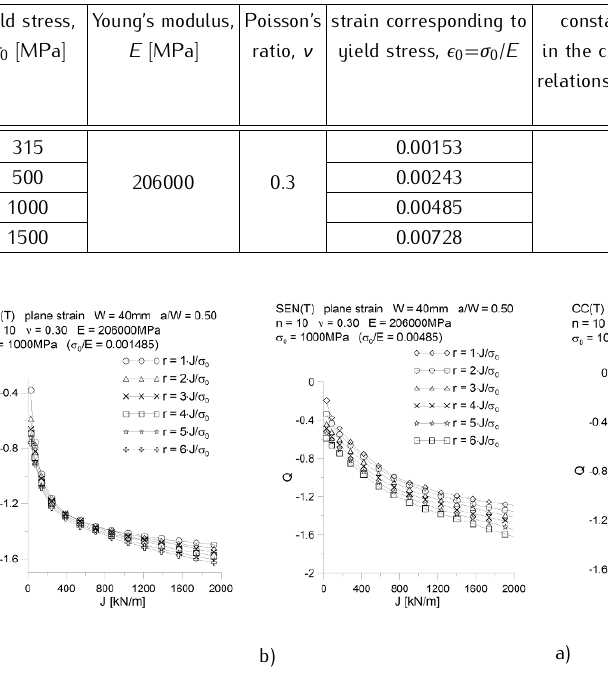
Table 3. The mechanical properties of the materials used in numerical analysis. yield stress, Young’s modulus, Poisson’s strain corresponding to